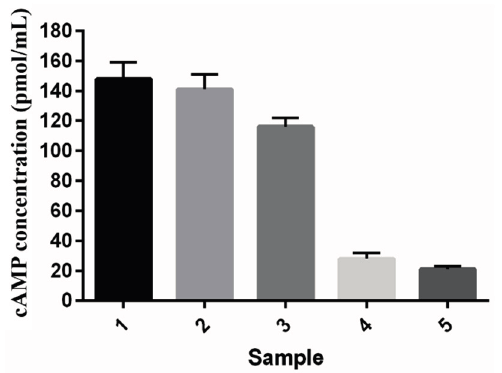
Figure 6. In vitro cyclic adenosine monophosphate (cAMP) activity on cell viability